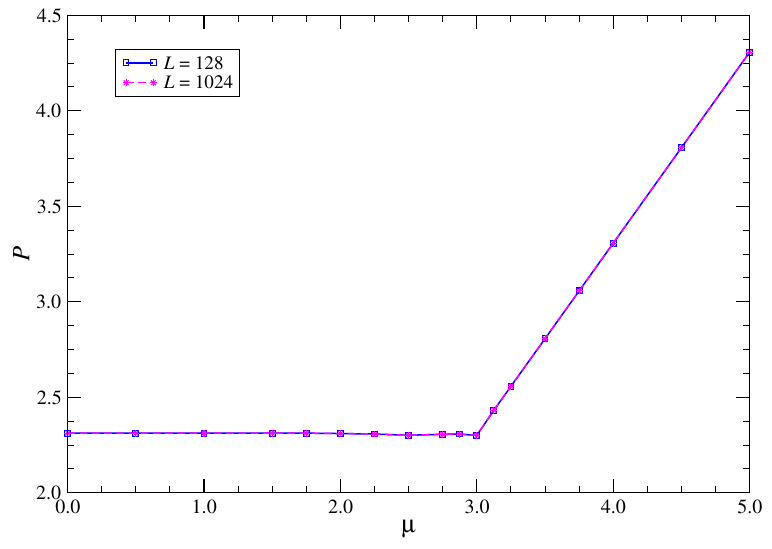
Figure 8 . Pressure at m = 0 . 01 as a function of µ on 128 4 and 1024 4